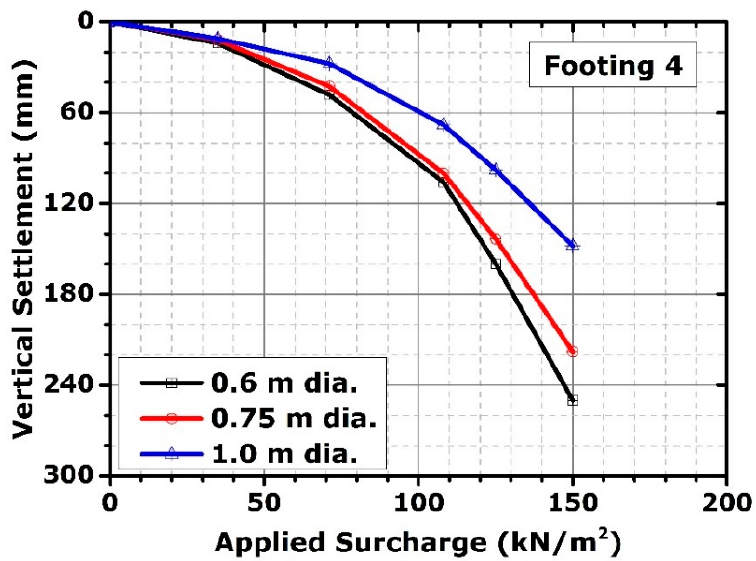
Figure 17. Influence of column diameter upon footing settlement in drained conditions—Footing 4.